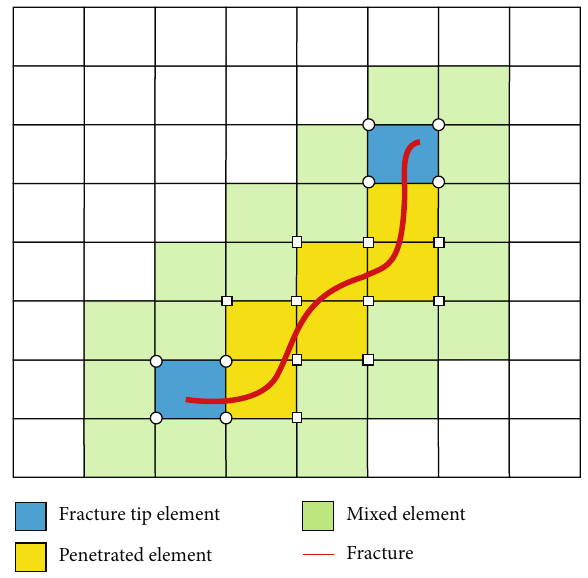
Figure 1: Meshes and nodes in the extended fi nite element